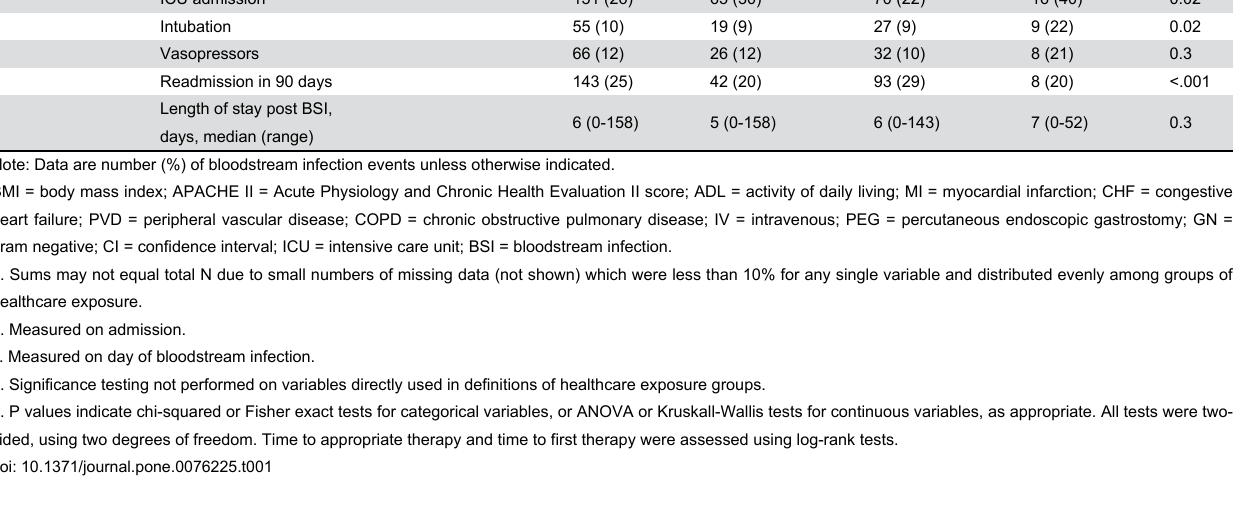
Table 2. Distribution of Gram-negative Bloodstream Infection